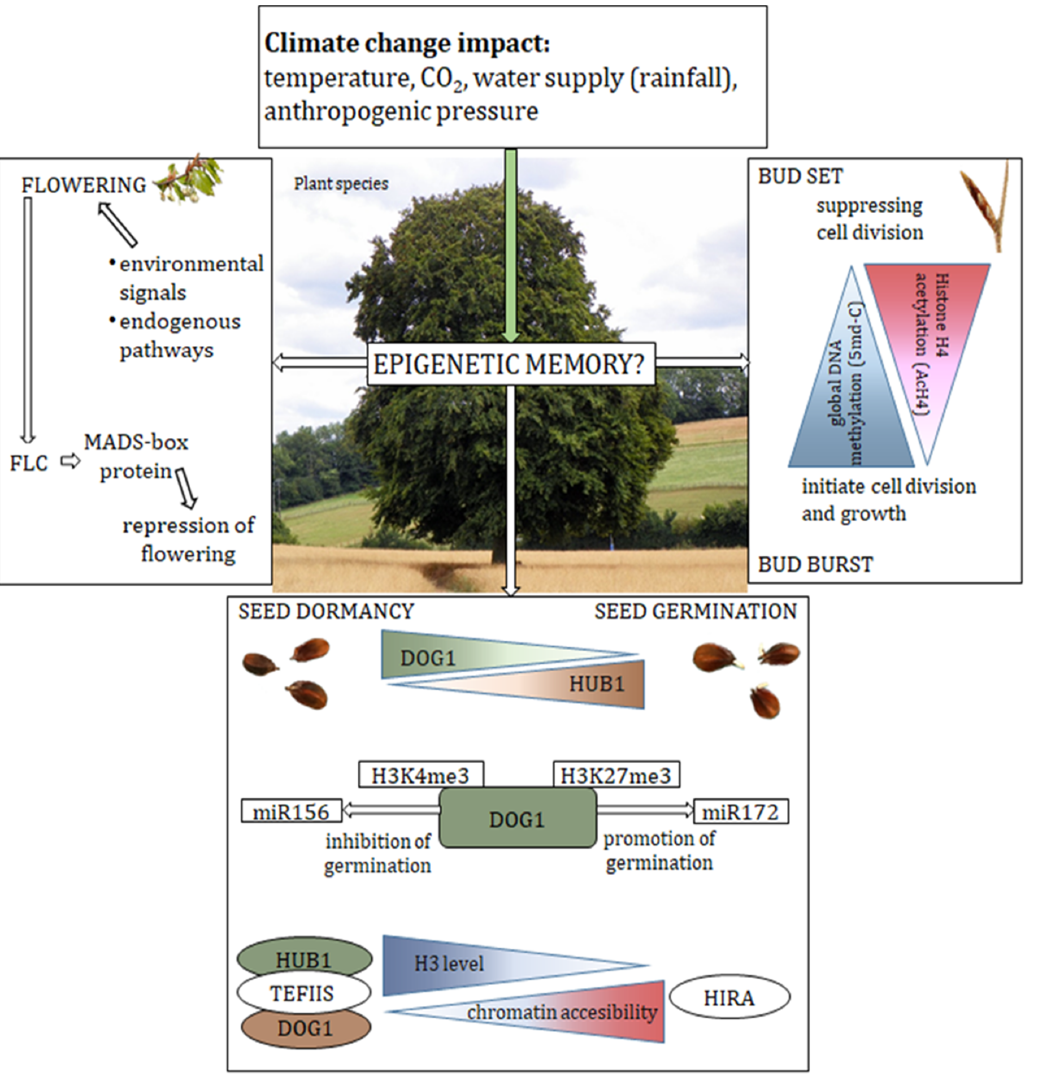
Figure 2. Epigenetic factors in the adaptive strategies of trees under the influence of environmental changes. Climate change caused by environmental factors such as temperature, CO 2 concentration, water supply, etc., can influence epigenetic regulations in the plant. This, in turn, may result in the adjustment of the mechanisms responsible for flowering or the seed germination and bud burst. FLC, Flowering Locus C; DOG1, Delay of Germination 1; TEFIIS, Translational Elongation Factor 2; HUB1, Histone Mono ‐ ubiquitination 1; HIRA, Histone Regulator A; H3K4me3, trimethylation of lysine 4 on histone H3; and H3K27me3, trimethylation of lysine 27 on histone H3.